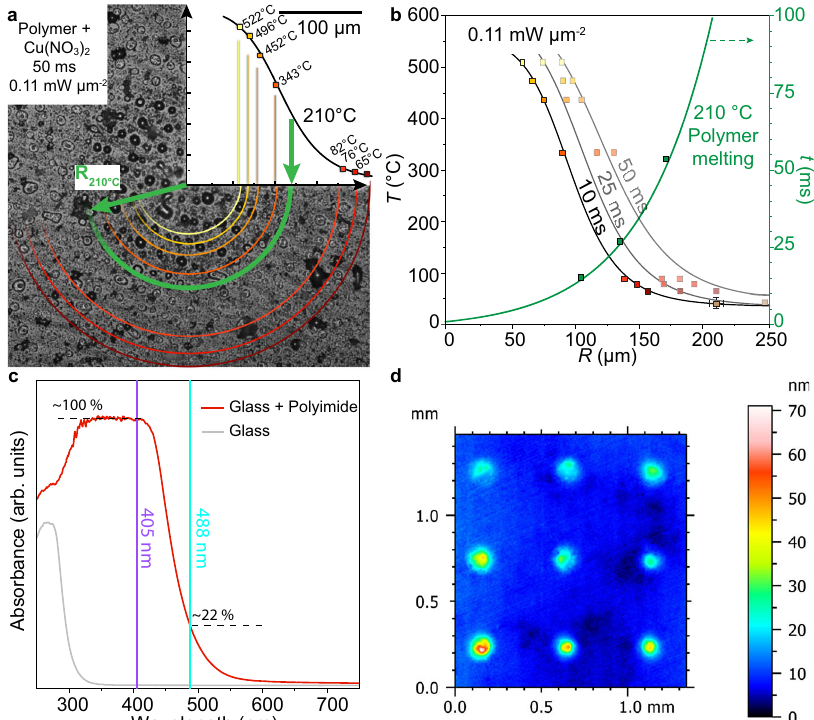
Fig. 3 Thermal characterization of the laser process. a Thermal map of a spot on a donor slide after 50 ms laser irradiation. Colored rings represent the overlay of isotherms. b Thermal pro fi les for different irradiation times and the radius of melting isotherm (green curve). c UV – VIS spectra of glass and polyimide-covered glass. d Vertical scanning interferometry (VSI) measurement of laser-transferred material spots in a gradient pattern (effective power density top to bottom 0.107, 0.132, 0.156 mW µ m − 2 , irradiation time left to right 40, 30, 20